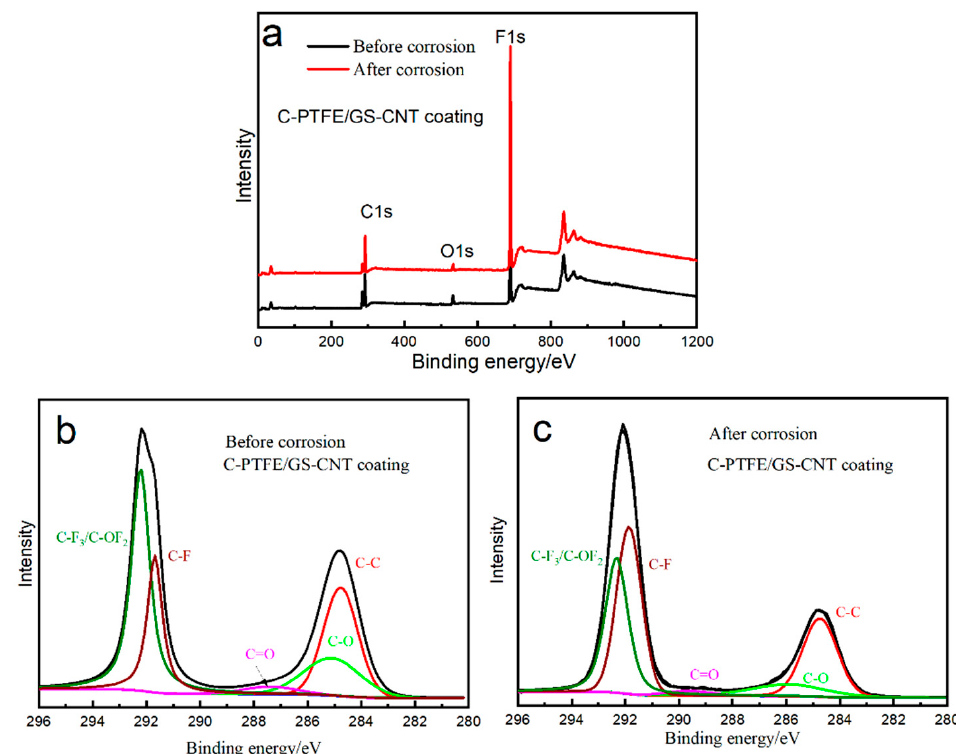
Figure 8. Survey spectra of coatings: ( a ) XPS analysis of C-PTFE/GS-CNT films before and after corrosion; ( b ) C1s spectra of C-PTFE/GS-CNT films before corrosion; ( c ) C1s spectra of C-PTFE/GS-CNT films after corrosion. Table 3. Fitting parameters and relative quantity analysis of compounds for C 1s spectra of C- PTFE/GS-CNT films before and after corrosion by XPS.